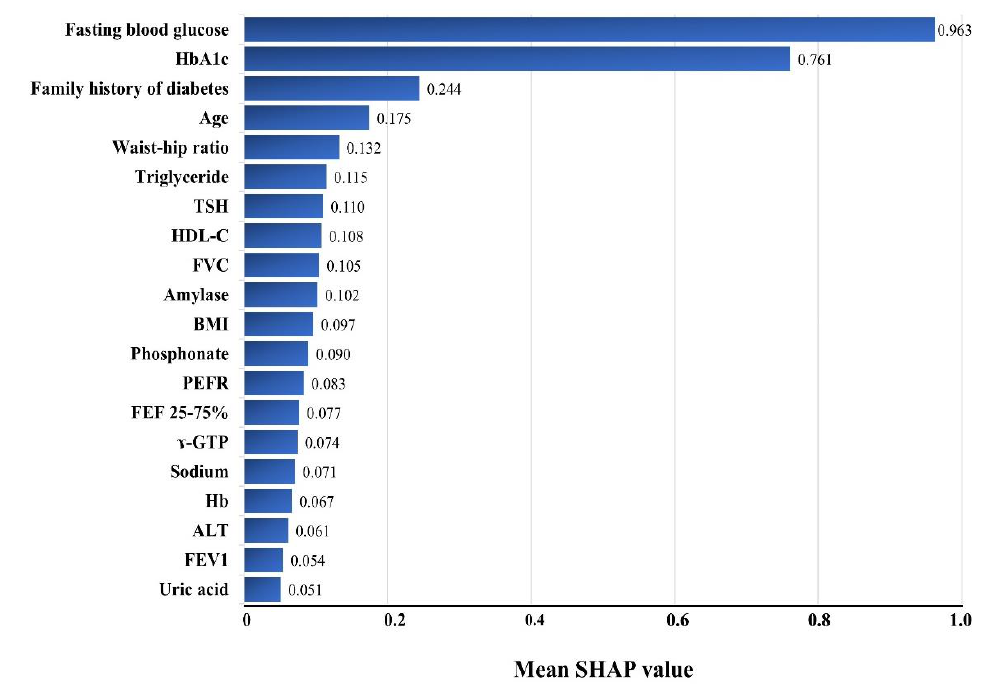
Figure 2. Variable importance in the XGBSE diabetes risk prediction models using the Shapley additive explanations (SHAP) approach. HbA1c — glycosylated hemoglobin; TSH — thyroid stimulating hormone; HDL — high-density lipoprotein; FVC — forced vital capacity; BMI — body mass index; PEFR — peak expiratory flow rate; FEF — forced expiratory flow; GTP — glutamyl transpeptidase; Hb — hemoglobin; ALT — alanine aminotransferase; FEV1 — forced expiratory volume in 1 s; SHAP — Shapley additive explanations. Table 2. Performance parameters of diabetes prediction models. AUROC Sensitivity Specificity PPV NPV Accuracy